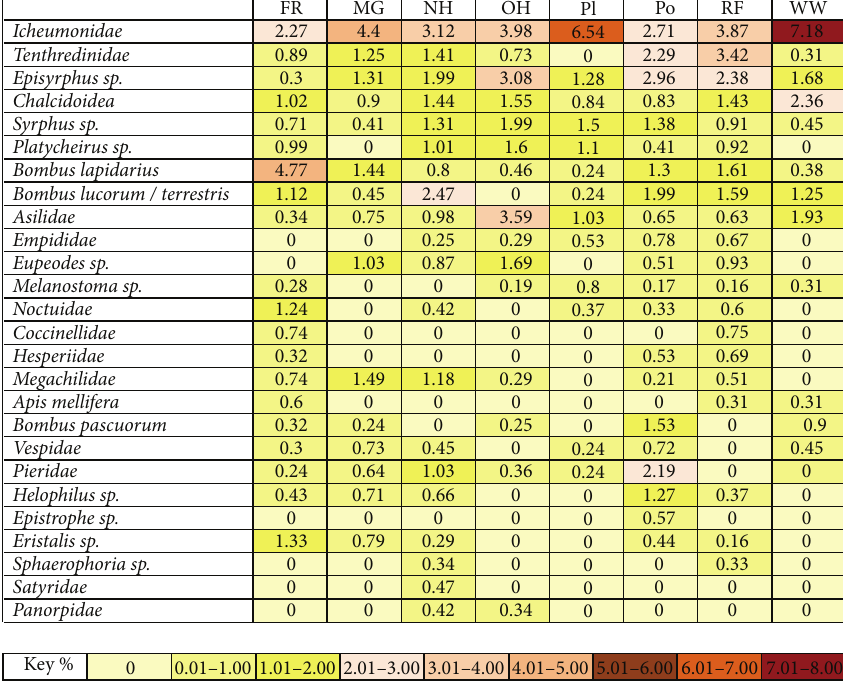
Figure 7: Heatmap-table summarising the relative abundance (%) of dominant taxon within each site, based on SIMPER analysis of count data recorded during the survey